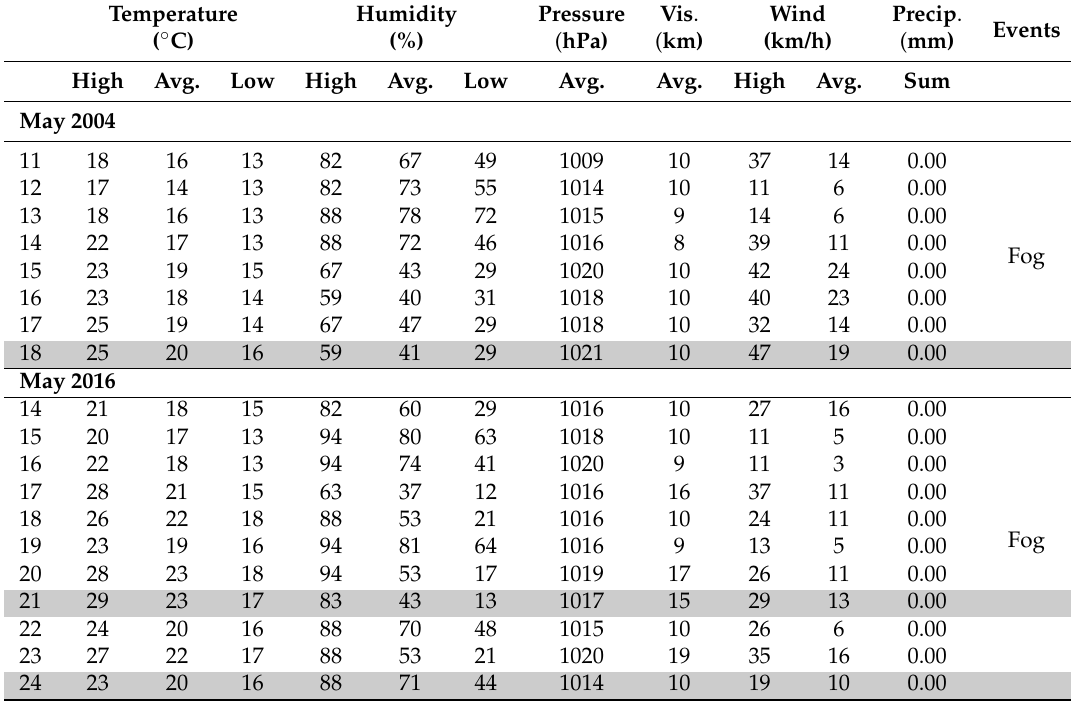
Table 1. Weather conditions in Almeria, Spain, in the week before the data acquisitions in 2004 and 2016 (indicated in grey). Data source is available online